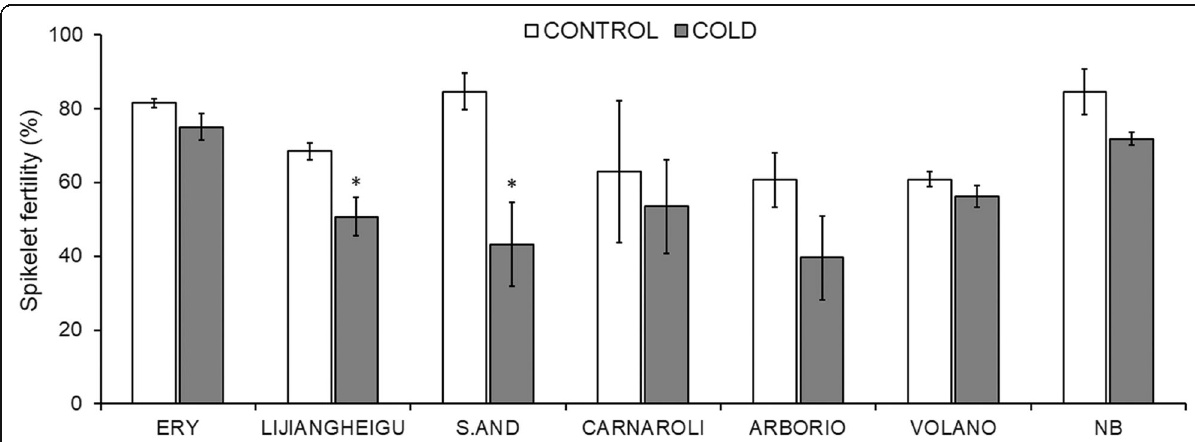
Fig. 1 Spikelet fertility in cold-stress tolerant and sensitive cultivars. Spikelet fertility as the percentage of filled/empty spikelets after grain maturation is shown. NB, Nipponbare. Bars represent mean ± SEM of at least two biological replicas. Asterisks indicate statistically different mean values compared with the control (Student ’ s t-test, p <